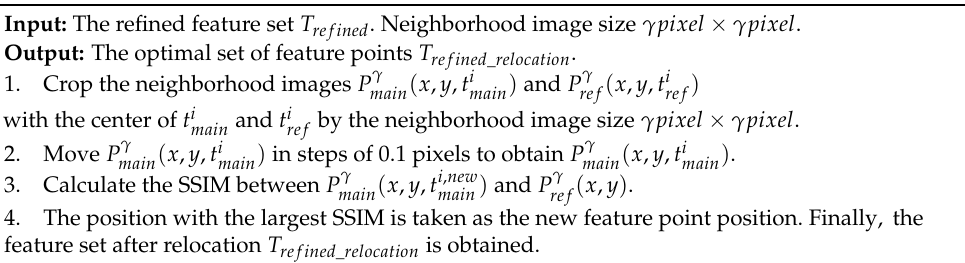
Table 2. The process of relocation based on